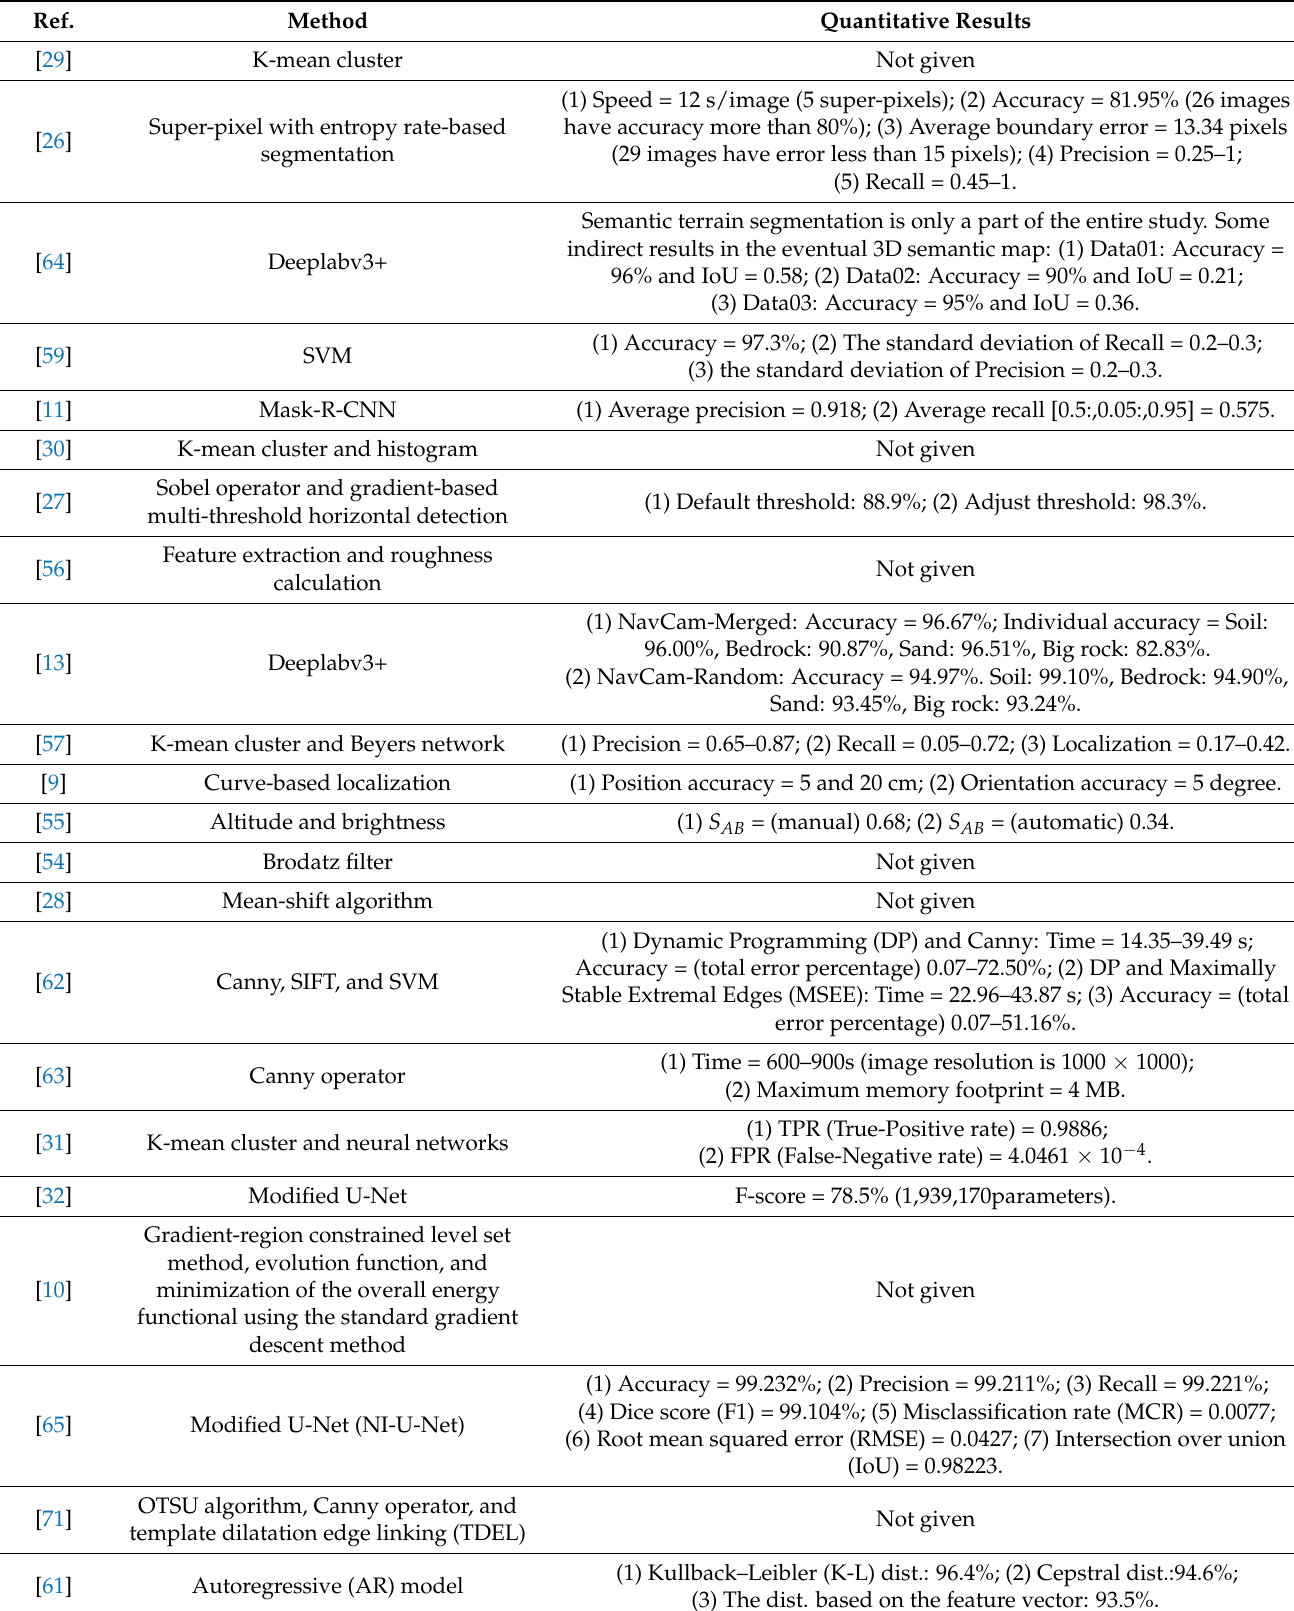
Table 3. The applied methods and quantitative results of the Included Study .